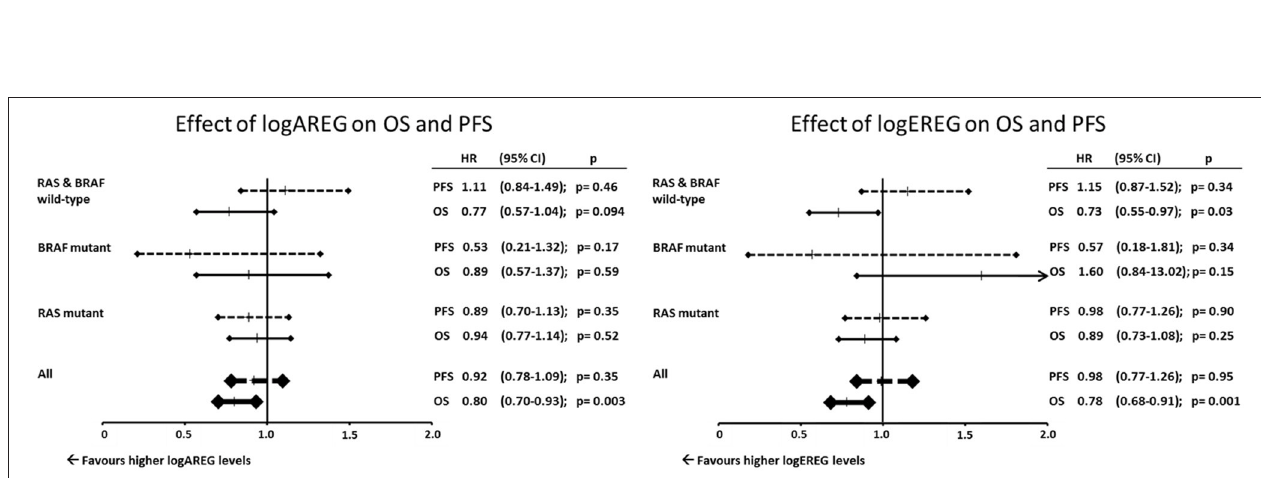
FIGURE 3 | Effect of logAREG on OS and PFS. Effect of logEREG on OS and PFS.